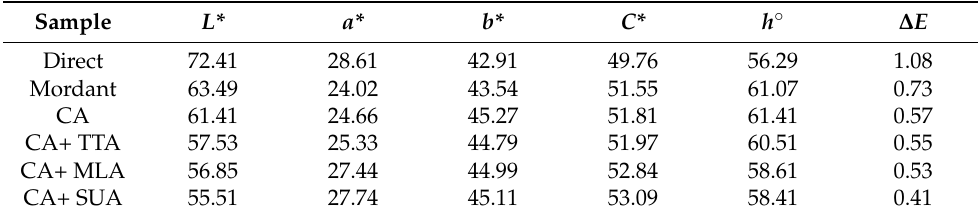
Table 3. Color characteristics, h ◦ values and ∆ E values of the direct, mordant and cross-linked dyed cotton